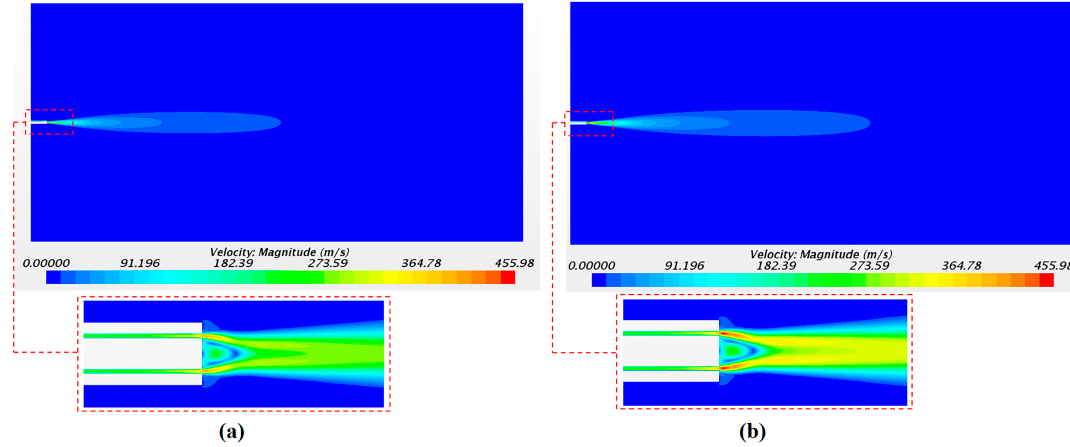
Figure 9. Continuous-phase velocity magnitude with a driving pressure of 4 bar ( a ) and 5 bar ( b Figure 9 . Continuous ‐ phase velocity magnitude with a driving pressure of 4 bar ( a ) and 5 bar ( b ).